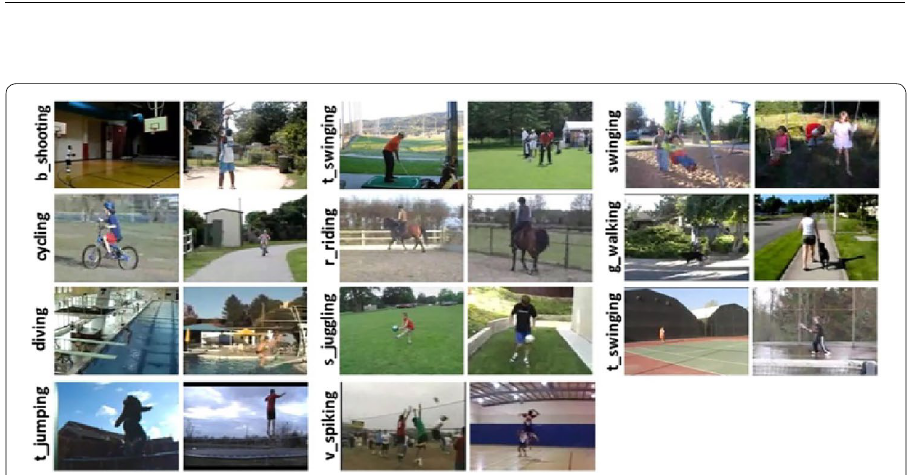
Fig. 7 Human actions in YouTube action